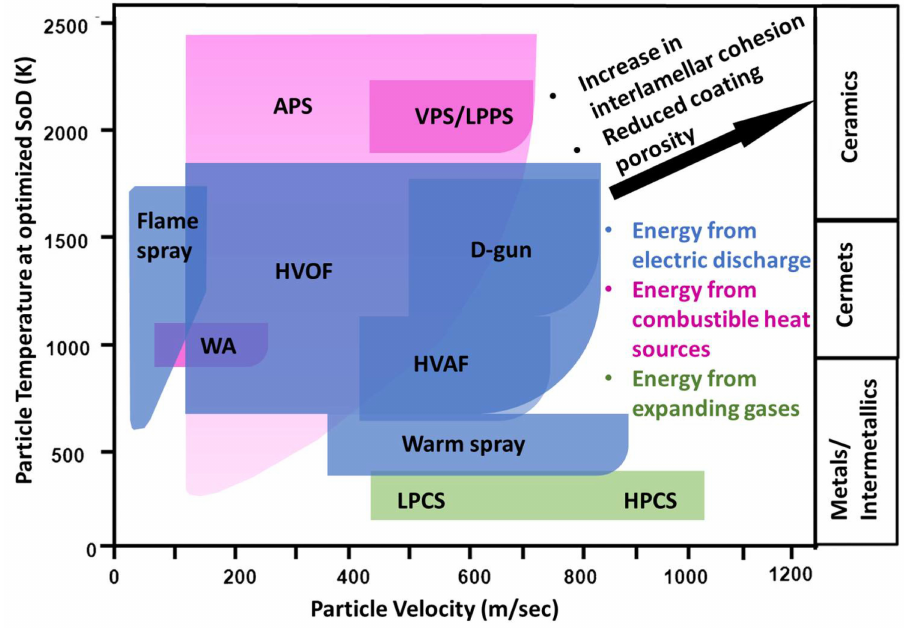
Figure 2. Simplified classification of thermal spray processes according to their source of heat generations, particle velocities and temperatures. APS = atmospheric plasma spray, VPS = vacuum plasma spray, LPPS = low pressure plasma spray, WA = wire arc, HVOF = high velocity oxygen fuel, D-gun = detonation gun, HVAF = high velocity air fuel, LPCS = low pressure cold spray, HPCS = high pressure cold spray, SoD = stand-off distance. Adapted with permission from [16]. 2014 Taylor &